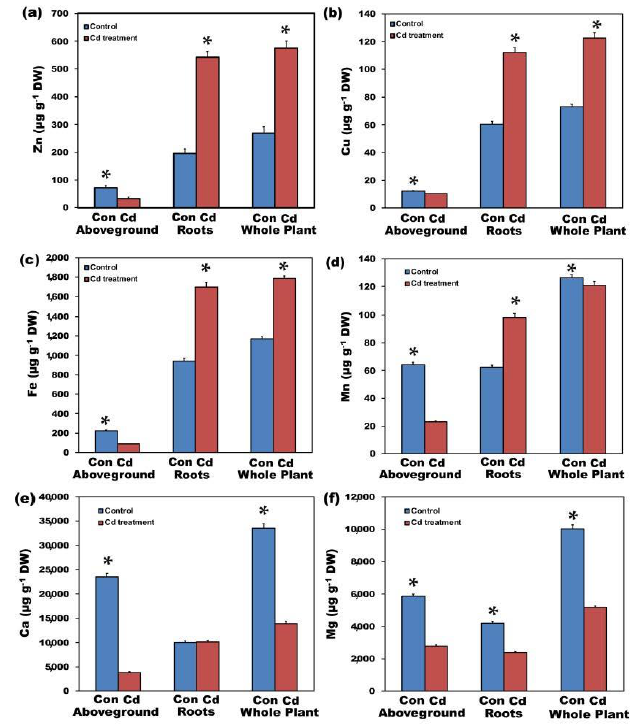
Figure 2. Zinc ( a ), Cu ( b ), Fe ( c ), Mn ( d ), Ca ( e ), and Mg ( f ) content, in µg g −1 dry weight, of control (con) and 5 days Cd-treated Salvia sclarea aboveground (shoots-leaves) tissues, roots, and whole plants. Error bars are standard deviations ( n = 5). Means between the two treatments that are statistically different ( p < 0.05) are marked by an asterisk (*).